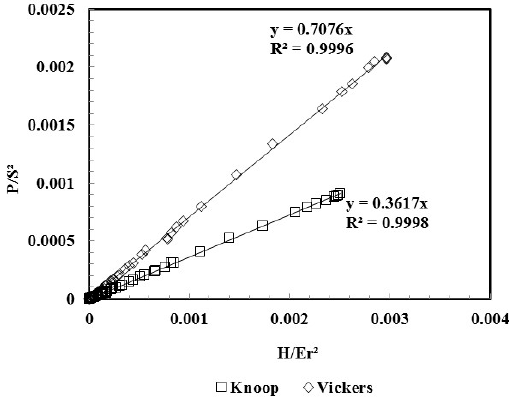
Figure 10. Evolution of the ratio P / S 2 as a function of H / E 2 r , obtained in the numerical simulations of all materials in Table 2, using the Knoop and Vickers indenters.